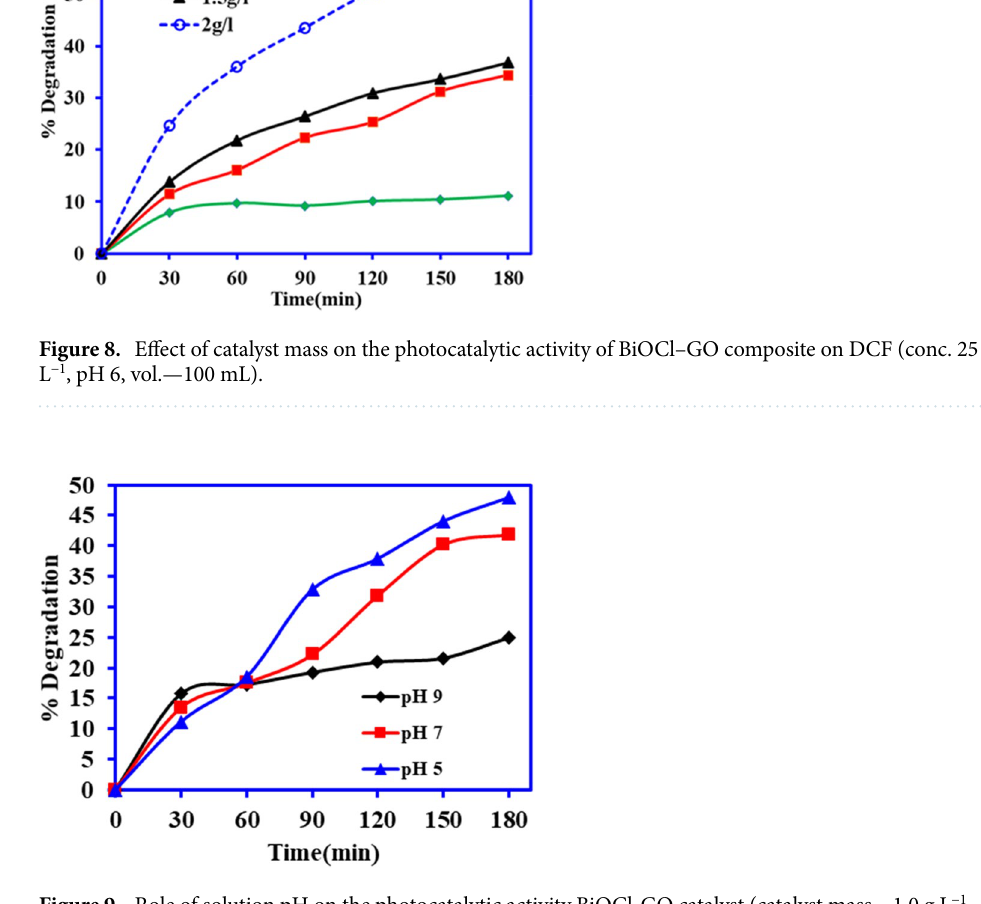
Figure 9. Role of solution pH on the photocatalytic activity BiOCl-GO catalyst (catalyst mass—1.0 g L −1 , vol.—100 mL, conc. 25 mg L −1 , light